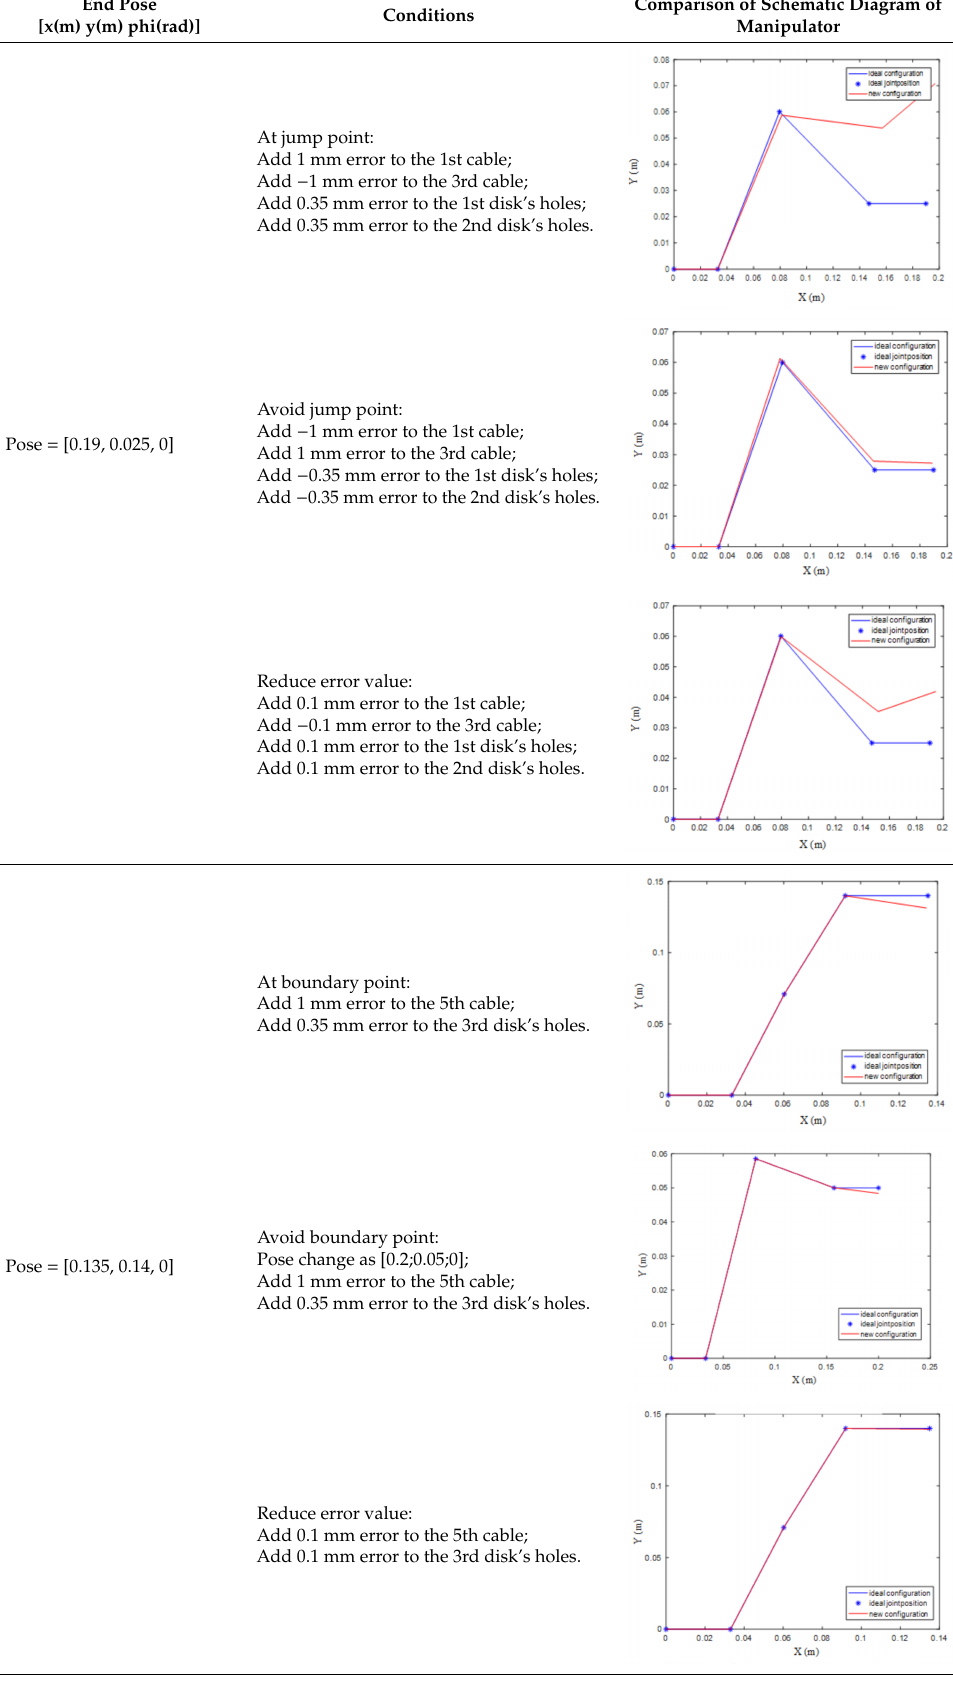
Table 2. Changes of the end pose under di ff erent